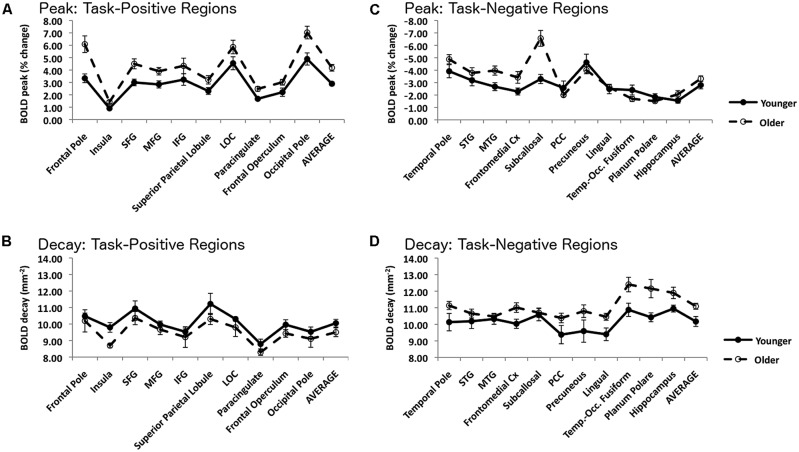
Top left, (A) Amplitude of the peak BOLD signal within each ROI in the task-positive network, measured with the smaller (3 mm) kernel. Bottom left, (B) Slope of the spatial decay of the BOLD signal within each ROI in the task-positive network. Top right, (C) Amplitude of the peak BOLD signal within each ROI in the task-negative network, measured with the smaller (3 mm) kernel. Bottom right, (D) Slope of the spatial decay of the BOLD signal within each ROI in the task-negative network. For all graphs error bars are based on the SE of the mean across subjects.